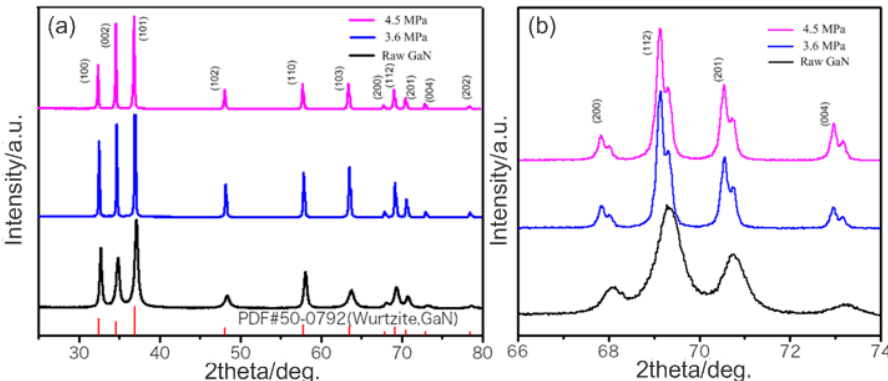
Figure 2. ( a ) XRD patterns of standard wurtzite GaN, GaN powders and as grown GaN polycrystals obtained under different pressure, ( b ) The peak of (200), (112), (201) and (004).